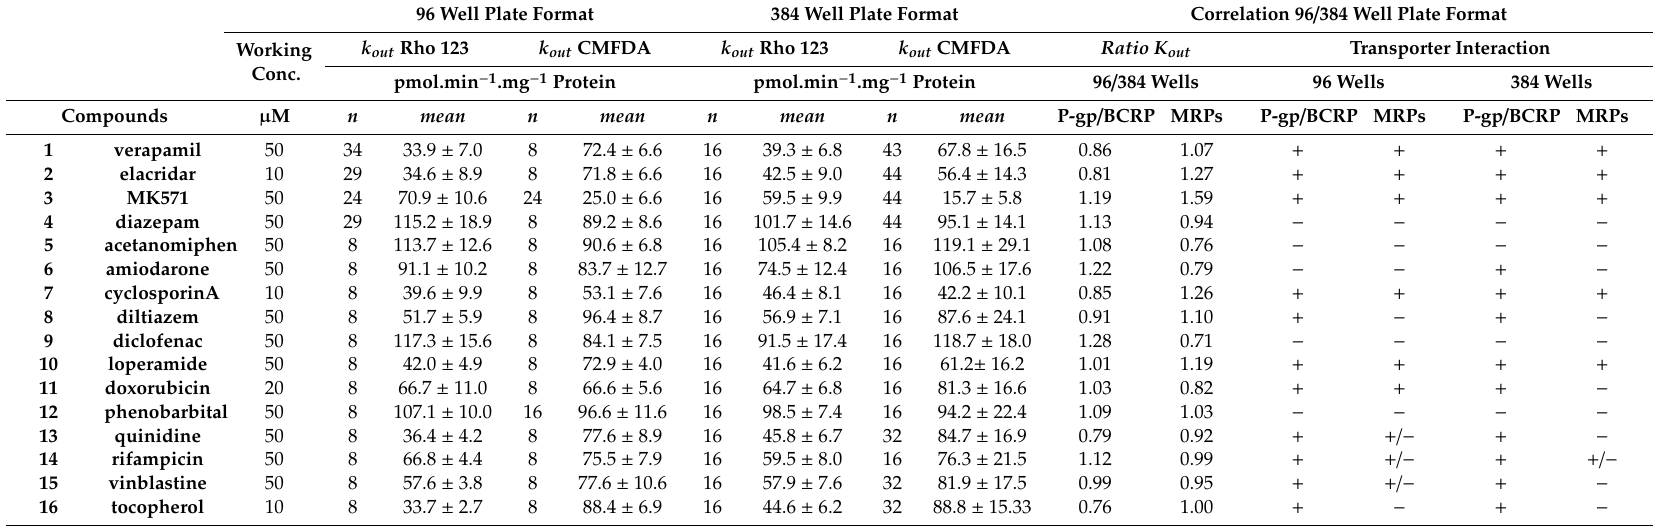
Table 1. Summary results of K out values of selected test compounds in Caco-2. K out rhodamine123 was 100.0 ± 8.1 ( n = 34) and 100 ± 12.1 ( n = 39) for 96- and 384-well plates. K out CMFDA was 100.0 ± 7.6 ( n = 34) and 100 ± 21.7 ( n = 39) for 96- and 384-well